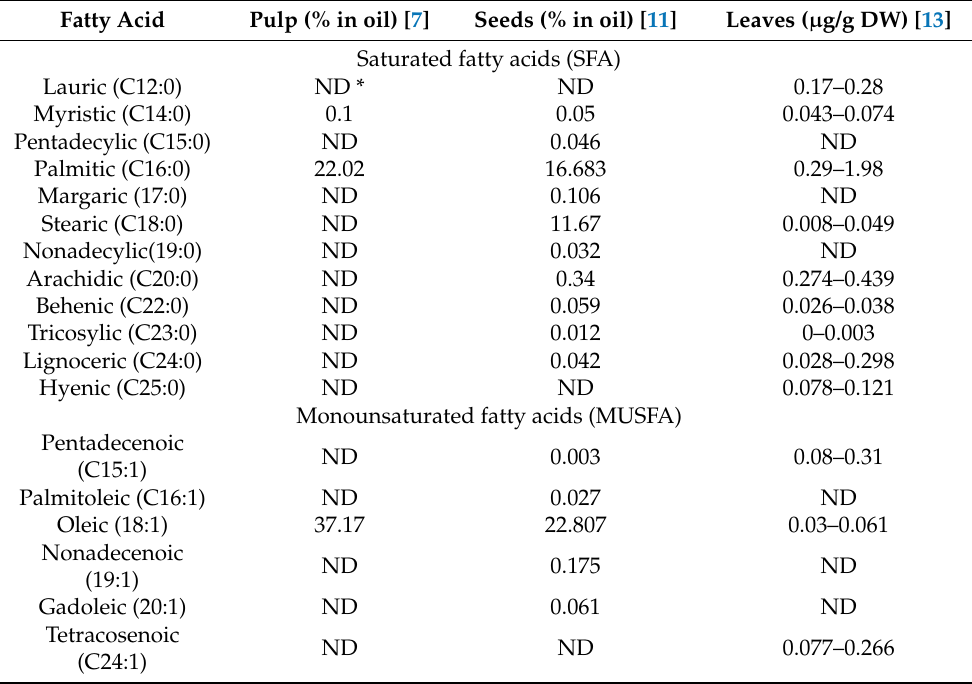
Table 2. Fatty acid composition of desert date pulp, seeds and